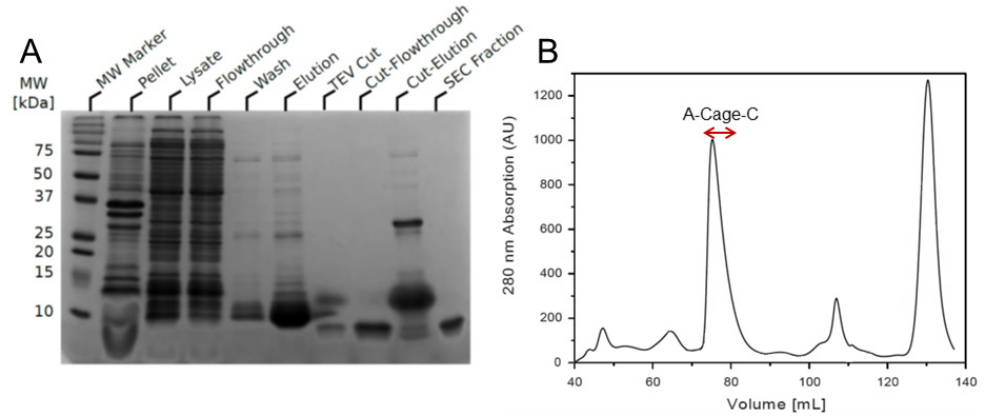
Figure 3. Expression and purification of 13 C, 15 N isotopically labelled A-Cage-C. ( A ) SDS-PAGE of A-Cage-C. SDS-PAGE of samples collected during purification of A-Cage-C. ( B ) Size-exclusion elution profile using a Superdex 75 16/60 HiLoad prepgrade. Volume fractions containing peptide were between 74–82 mL, indicated by the red arrow brackets.